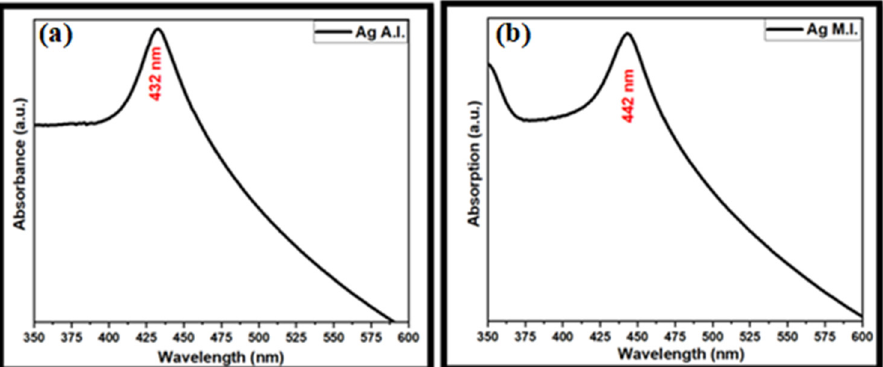
Figure 4. UV-Vis absorbance spectrum of AgNPs as a function of 1 mM AgNO 3 concentration in aqueous extracts of fresh leaves of A. indica ( a ) and M. indica ( b )